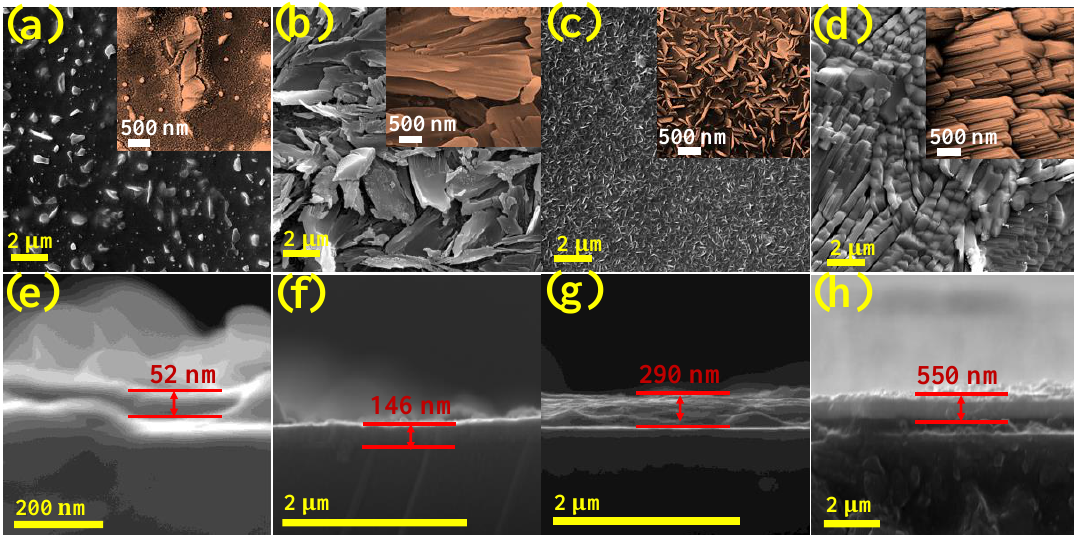
Figure 2. Field-emission scanning electron microscopy (FE-SEM) images of W 18 O 49 films deposited for ( a ) 1, ( b ) 5, ( c ) 10, and ( d ) 20 min. and FE-SEM cross-section images of W 18 O 49 films deposited for ( e ) 1, ( f ) 5, ( g ) 10, and ( h ) 20 min. All the films were annealed at 500 °C in air.